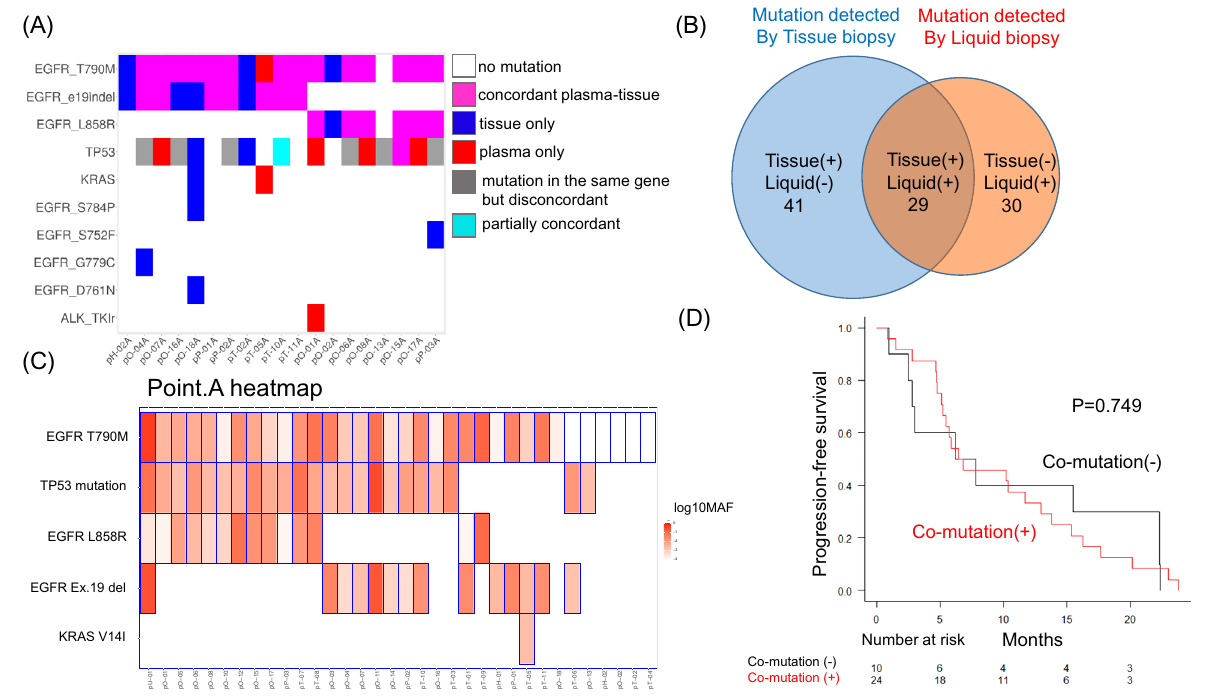
Figure 5. ( A ) Oncogene mutation concordance chart for mutated genes across patients analyzed by tissue– liquid-matched pairs. A total of 19 patients were tested using both NOIR-SS NGS assays. The detected mutations were colored according to the concordance status. ( B ) Mutation fractions of the shared versus tissue- or liquid- only mutations. ( C ) Heatmap of ctDNA mutations detected by liquid biopsy at point A. The detected mutations were colored based on the basis of their log 10 VAF values. The mutation with the highest VAF value was selected in this heatmap when multiple mutations were detected for TP53. ( D ) Kaplan–Meier plot of PFS for osimertinib treatment. Comparison of PFS between co-mutation(−) and co-mutation( +) groups. p -value = 0.749.